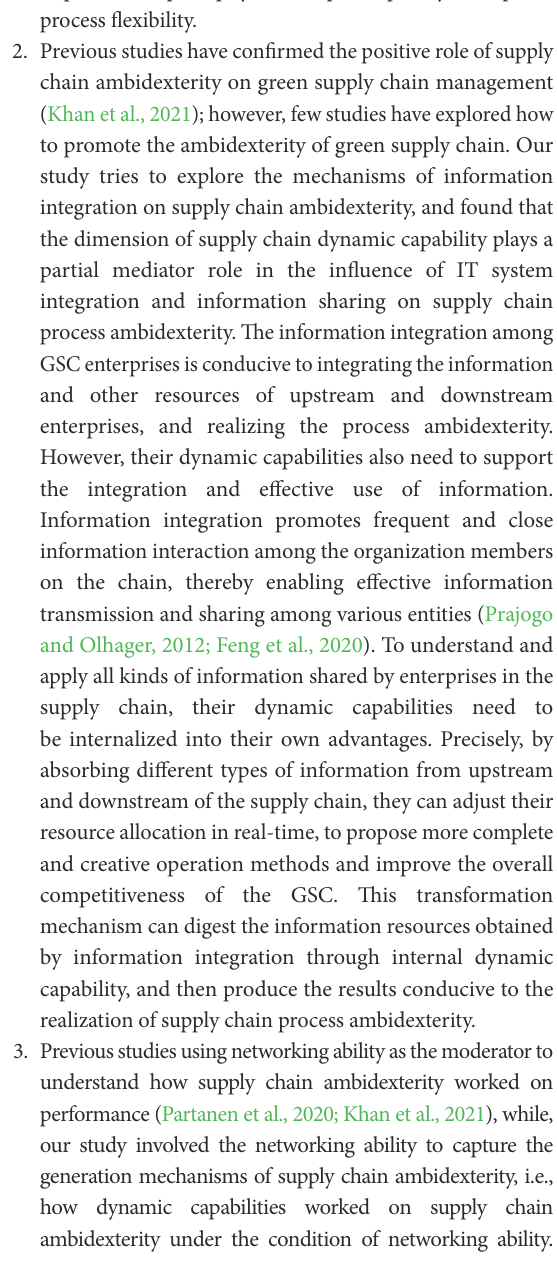
TABLE 5 Significance analysis of the direct